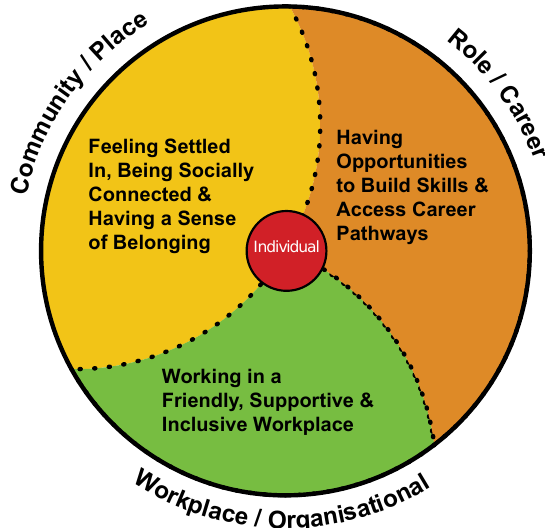
Figure 1. The ‘Whole-of-Person’ Retention Improvement Figure 1. The ‘ Whole-of-Person ’ Retention Improvement Framework.